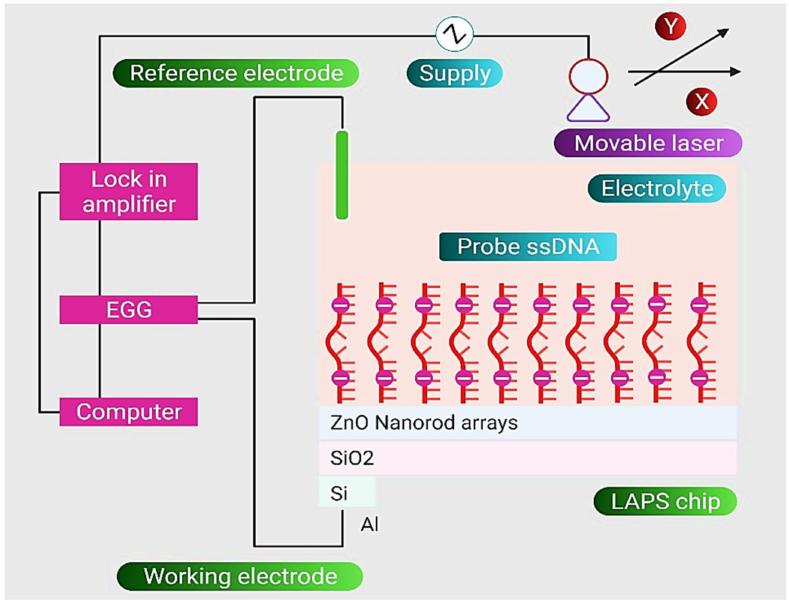
Figure 9. Schematic diagram of the nanosensor arrangement, built up from ZnO nanorods arrays, probe ssDNA, and silica layer for detection of E. coli . Reprinted from Ref.